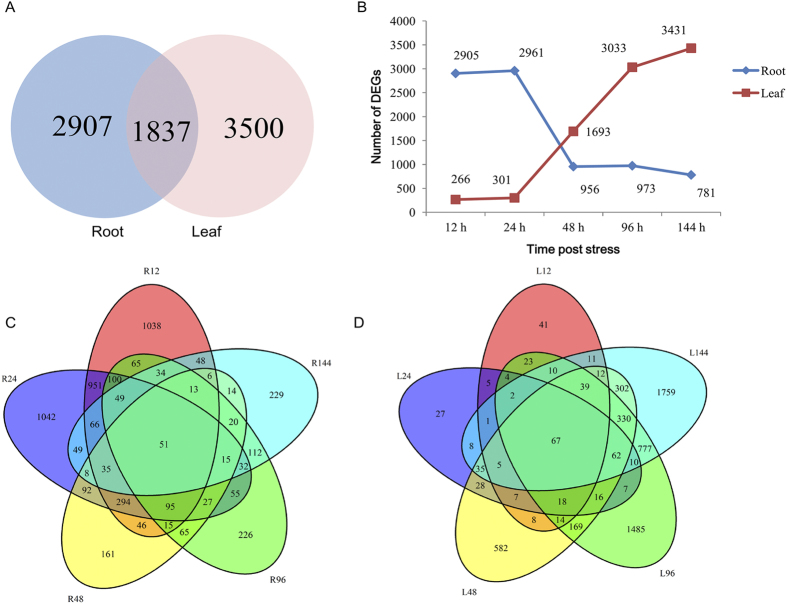
Analysis of global differential expressed genes.(A) DEGs in roots and leaves under salt stress. (B) Number of DEGs in each of the samples at five time points. (C) Venn diagram of the 4,744 DEGs in roots. (D) Venn diagram of the 5,337 DEGs in leaves.